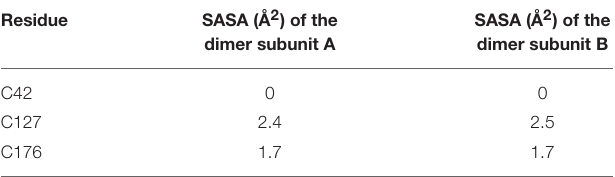
TABLE 2 | Theoretical solvent accessible surface area (SASA2) of cysteine containing residues in SyTPI calculate by ANCHOR (Meireles et al., 2010). Residue